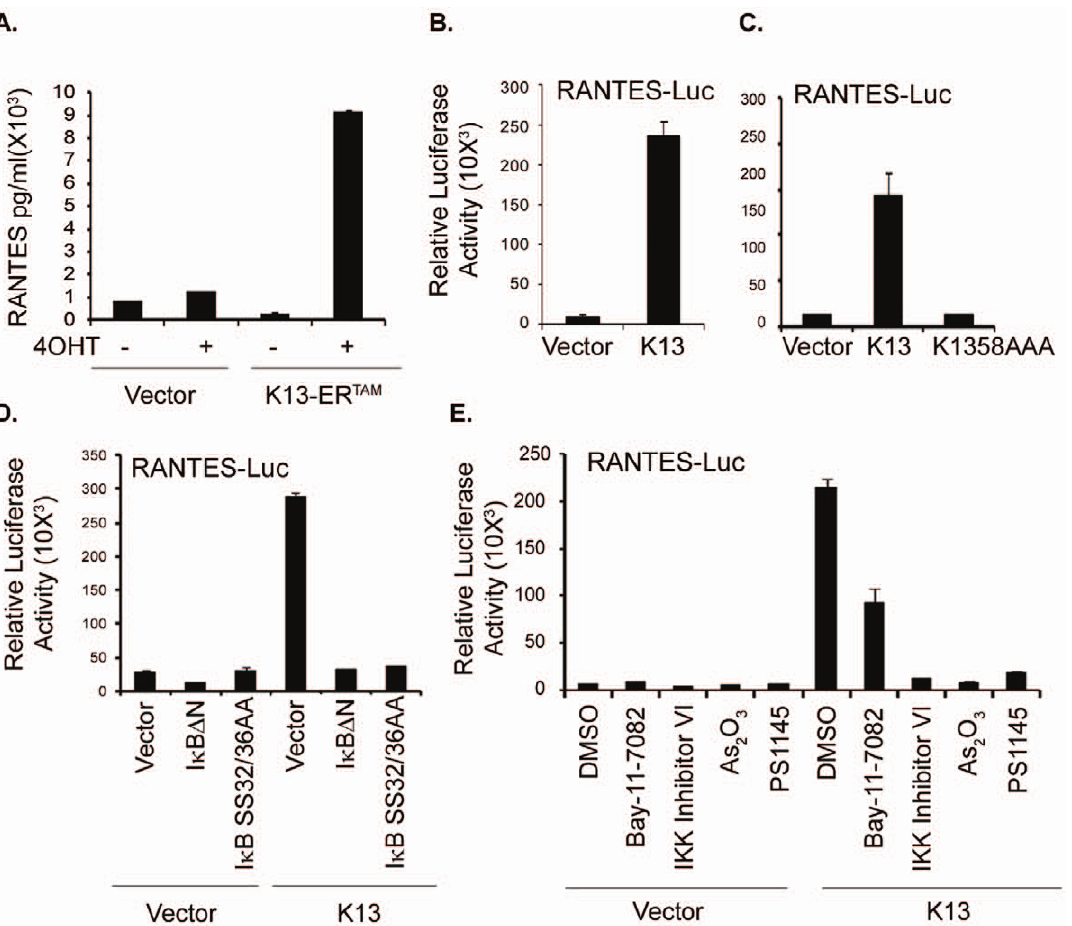
Figure 4. K13-induced NF- k B activity is critical for the activation of RANTES. (A) K13-induced up regulation of RANTES at protein level. Cellular supernatant from BCBL1 vector and K13-ER TAM cells treated with and without 4OHT were collected and used to measure the secretion of RANTES by ELISA. The values shown are averages (mean 6 SE) of one representative experiment out of three in which the level of RANTES secretion was measured in triplicate. (B–C) 293T cells were transfected with an empty vector, wild-type K13 (B) or K13-58AAA (C) (250 ng/well) along with a RANTES promoter-driven luciferase constructs (75 ng/well) and a pRSV/LacZ ( b -galactosidase) reporter construct (75 ng/well), and the reporter assay performed as described under the Materials and Methods section. (D) Dominant-negative mutants of I k B a (I k B aD N and I k B a SS32/36AA) block K13- induced RANTES promoter activity. 293T cells were transfected either with the indicated plasmids and reporter assay performed as described above. The amount of I k B a mutant plasmids (500 ng/well) was five times the amount of vector or K13 (100 ng/well) plasmid and the total amount of transfected DNA was kept constant by adding empty vector. (E) Pharmacologic inhibitors of NF- k B block K13-induced RANTES promoter activation. 293T cells were transfected with an empty vector or a vector encoding K13 along with RANTES-Luc and pRSV/LacZ reporter constructs. Approximately 3 hours after transfection, cells were treated with dimethyl sulfoxide (vehicle) or the indicated compounds for 18 hours before cell lysis and measurement of reporter activities. Reporter assay was performed as described for Figure